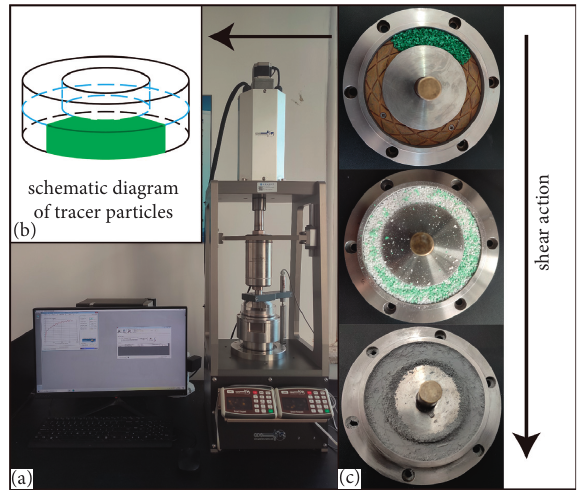
Figure 1: Diagrams of the experimental apparatus. (a) GDS ring shear instrument. (b) Schematic diagram of the initial position of the tracer particles. (c) Photograph of tracer results. Table 1: Parameters of the